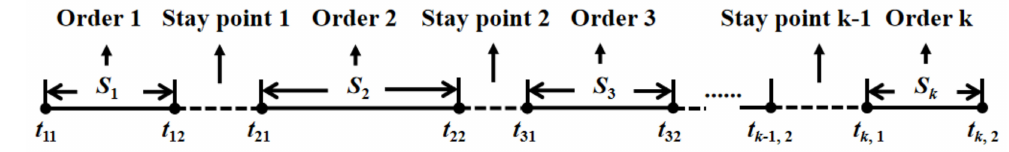
Figure 8. A car sharing order that has been split into k taxi suborders.